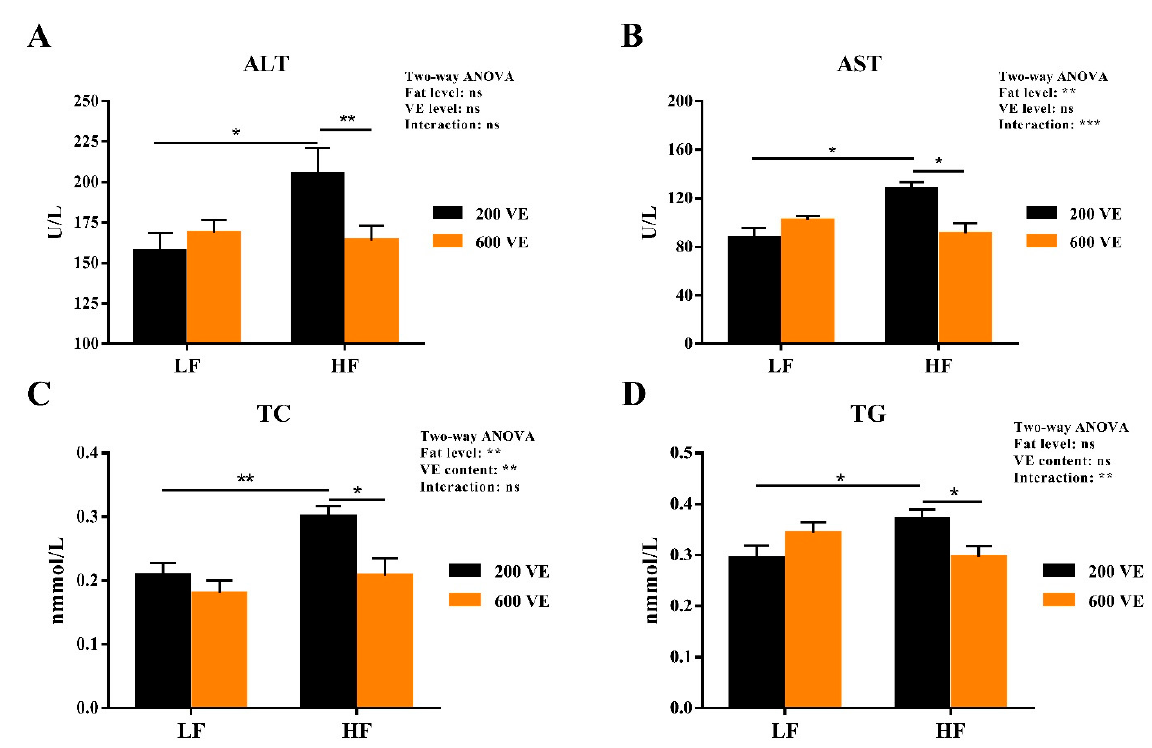
Figure 2. Hemolymph biochemistry parameters of Macrobrachium rosenbergii fed with different dietary fat and VE levels. ( A ) hemolymph alanine aminotransferase (ALT) activity of M. rosenbergii fed with different dietary fat and VE levels; ( B ) hemolymph aspartate aminotransferase (AST) activity of M. rosenbergii fed with different dietary fat and VE levels; ( C ) hemolymph total cholesterol (TC) content of M. rosenbergii fed with different dietary fat and VE levels; ( D ) hemolymph total triglycerides (TG) content of M. rosenbergii fed with different dietary fat and VE levels. Values are means ± SEM. ***: p < 0.001, **: p < 0.01, *: p < 0.05, ns: p < 0.05.